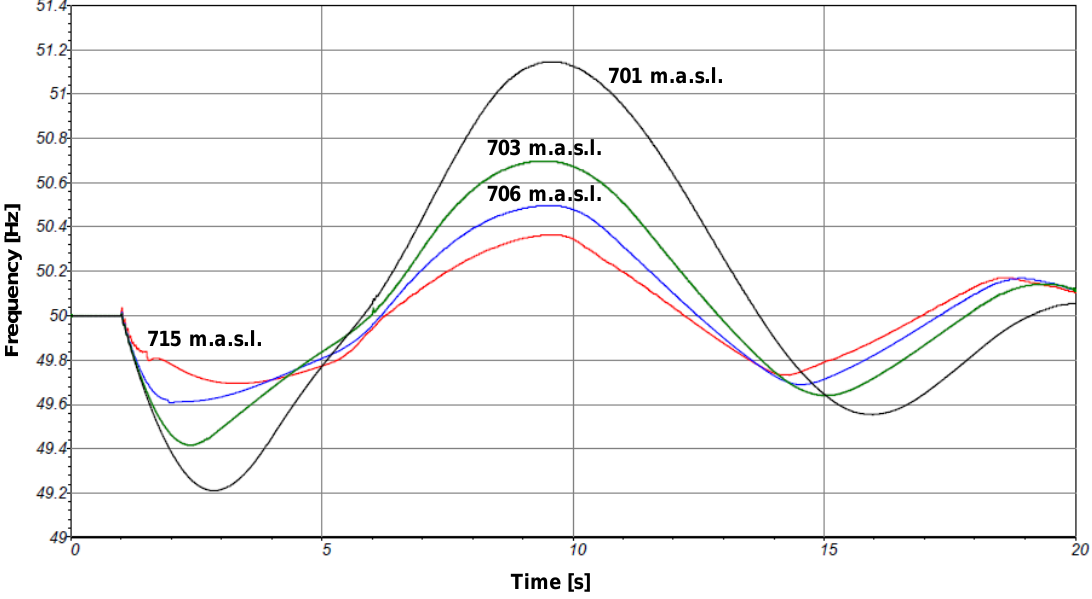
Figure 12. Frequency in the power system after a wind generator trip for different upper reservoir levels (20 s) after a 2.3 MW wind generator trip.